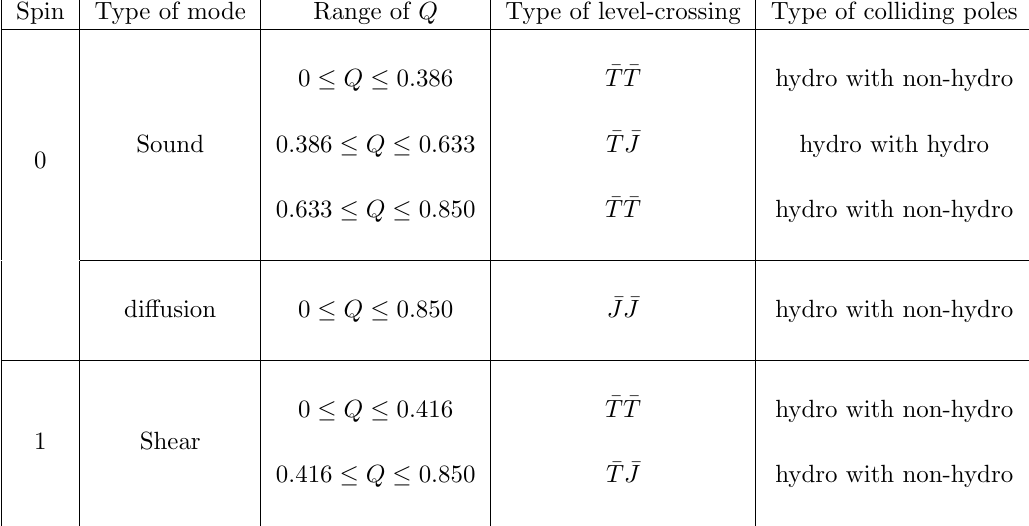
Table 1. We have classi(cid:12)ed all di(cid:11)erent types of level-crossing in terms of spin, the value of Q and type of colliding poles. For example, the second row of the table is saying that sound mode is an eigen frequency for the spectral curve of spin 0 (cid:13)uctuations. When 0 : 386 (cid:20) Q (cid:20) 0 : 633, the derivative expansion associated with dispersion relation of sound converges; the radius of convergence is identi(cid:12)ed with the collision of a hydrodynamic mode, actually the sound pole itself, belonging to the spectrum of master energy density (cid:22) T L , and a non-hydrodynamic mode, which is actually gapped and comes from the spectrum of (cid:22) J L